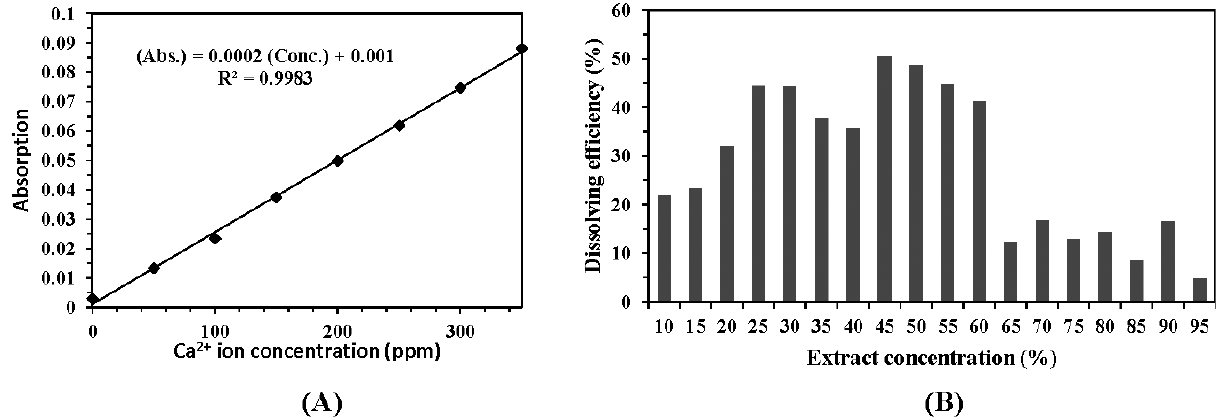
Figure 5: Dissolving capability of the G. aretioides extract (a) standard graph for absorption versus calcium ion concentration by using the calcium chloride solutions (b) impact of different amount of root extract on percent of solubilized calcium ions. (Abs.) refers to “Absorption” and (Conc.) is “Calcium ion concentration”.